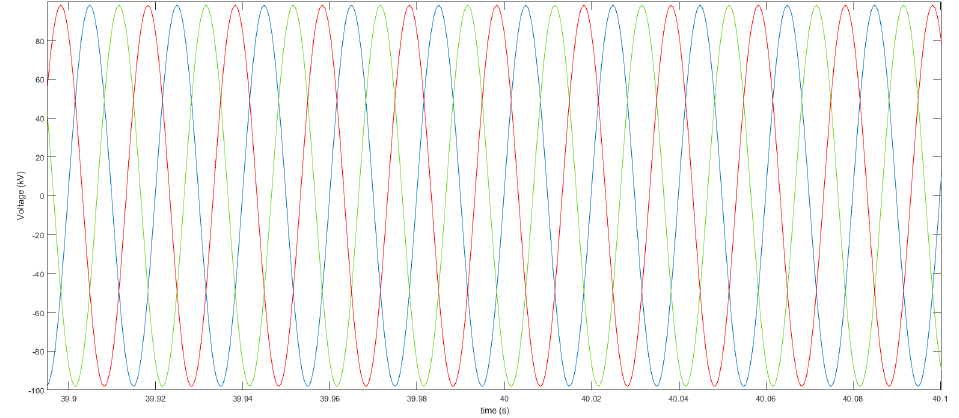
Figure 14. Three phase voltages at bus 3 of the